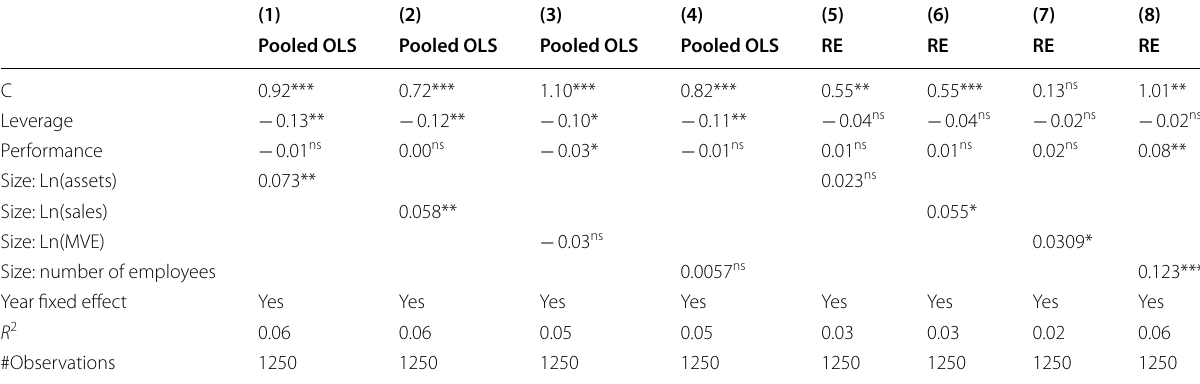
F test Chi2(3) p value